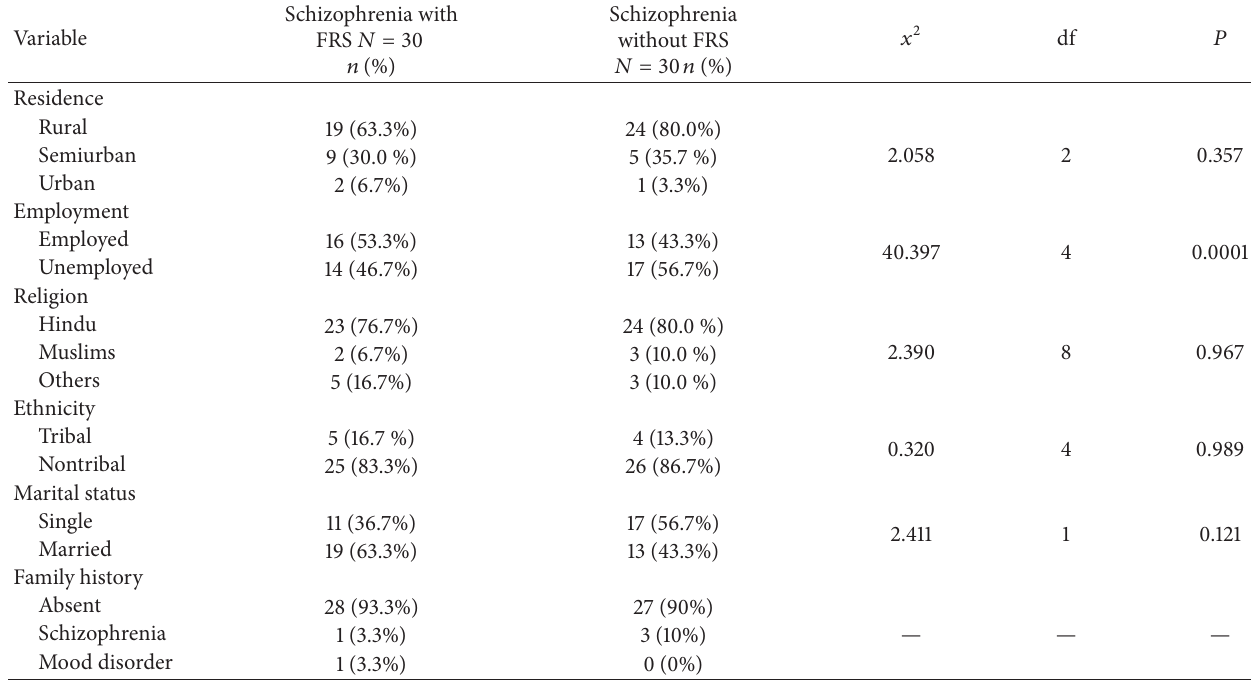
Table 2: Comparison of sociodemographic characteristics (categorical variables: residence and employment) between patients of schizophrenia with and without first rank symptoms (FRS).